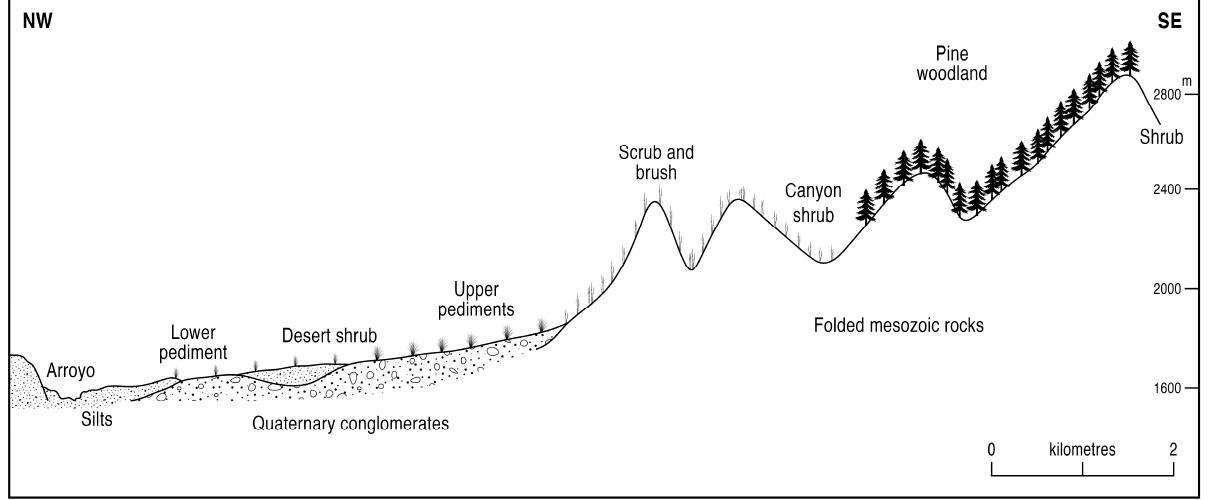
Figure 3. Long valley profile of the Upper Arroyo basin cross-cutting the bottom, piedmont, and highland zones; transect from the Upper Arroyo site to the southwestern corner of Figure 2.